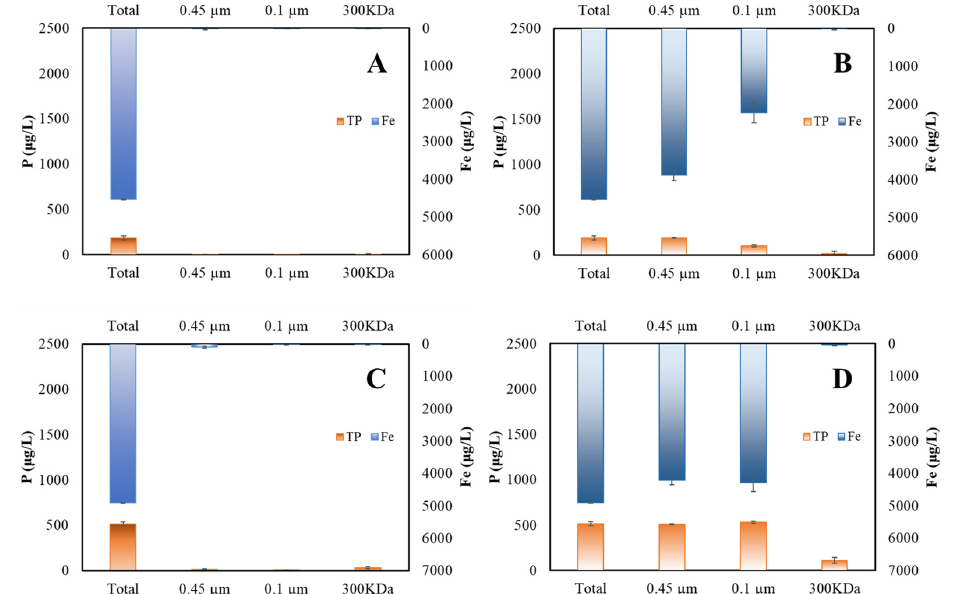
Figure 5. Size distribution of P and Fe after in-situ ferrate (VI) treatment of different DOP model compounds: ( A ) DNA in-situ at pH 6.5; ( B ) DNA in-situ at pH 7.5; ( C ) ATP in-situ at pH 6.5; and ( D ) ATP in-situ at pH 7.5. (initial DOP = 1000 μ g/L as P; Fe (VI) = 5.0 mg/L).